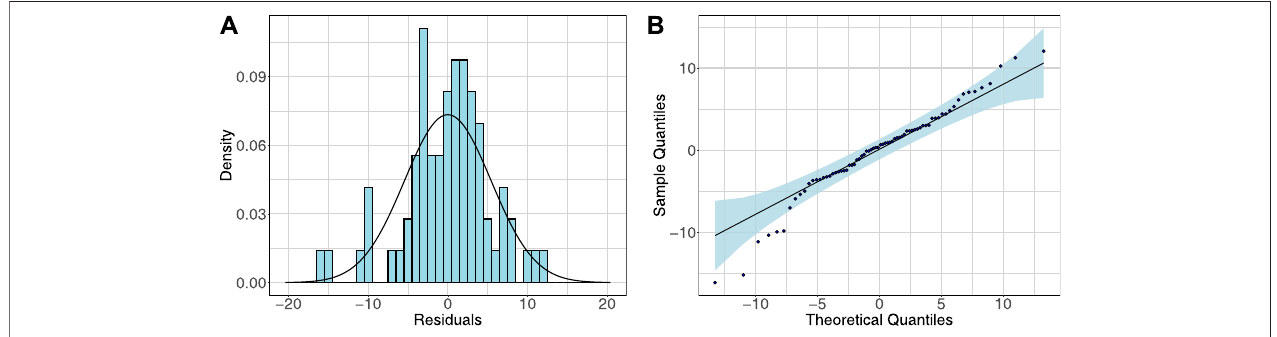
FIGURE 1 | (A) Histogram of the residuals for the model (M 1 AEM ), with fi tted normal curve (B) A QQ plot of the residuals.